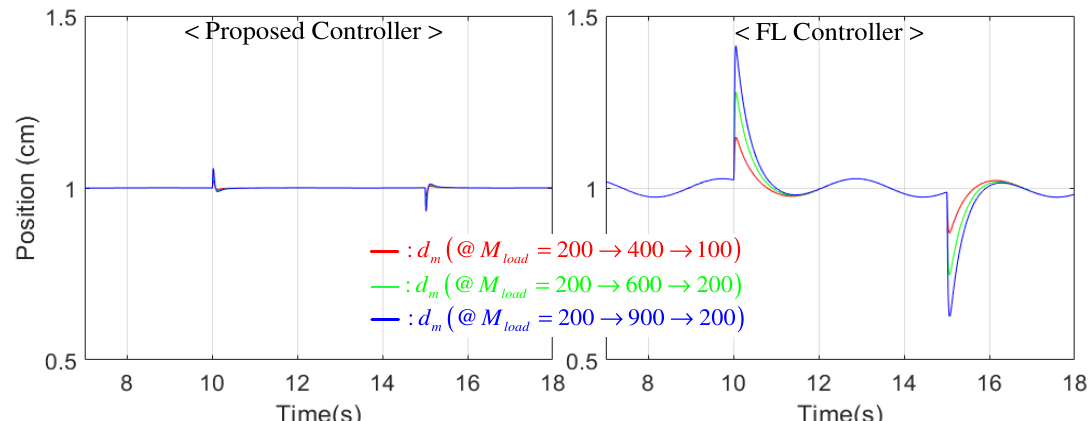
Figure 6. Position regulation performance comparison results for three load mass variation scenarios under external disturbances of f ext ,1 ( t )